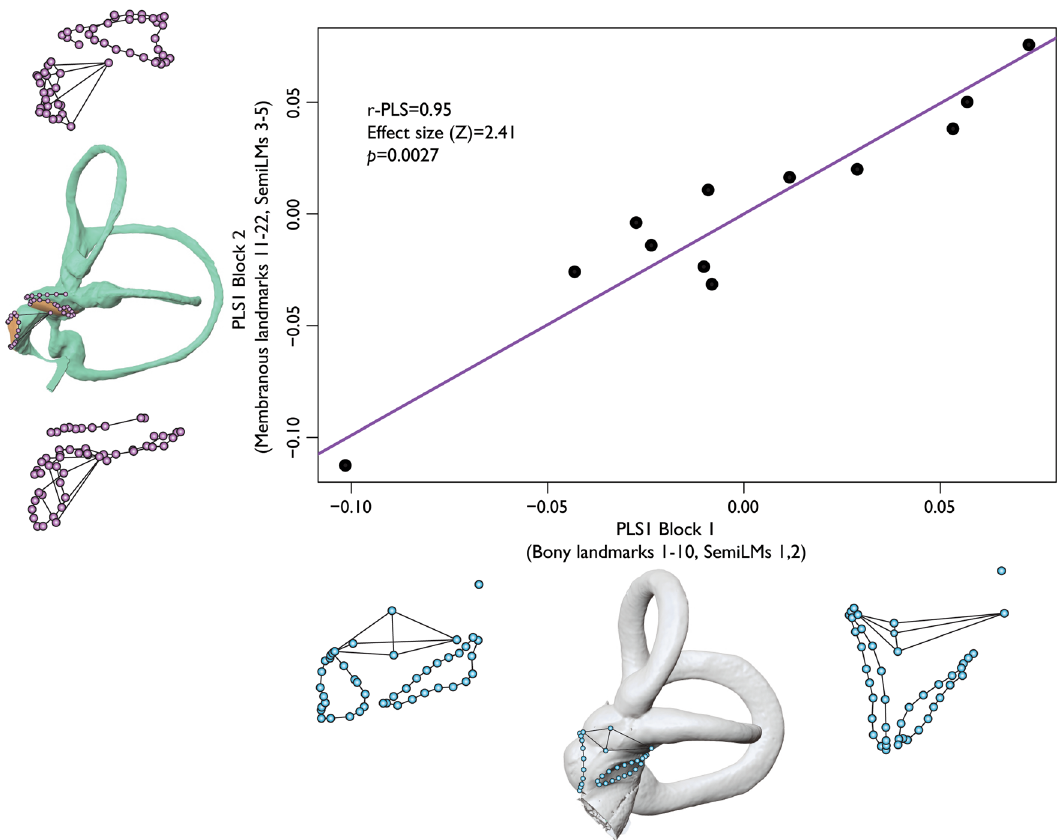
Figure 4. Integration plot from the 2B-PLS analysis. Data show significant correlation of overall shape variation between Procrustes superimposed landmark coordinates on bony and membranous otolith organ structure. Wireframes show extremes of shape variation for each block that covaries with the other block. The x-axis shows the extent of shape variation in bony landmarks and sliding semilandmark curves (shown in blue). The y-axis shows the extent of shape variation in membranous landmarks and sliding semilandmark curves (shown in purple). Center images of the x and y axes depict mean landmark configurations superimposed on the bony or membranous labyrinth,